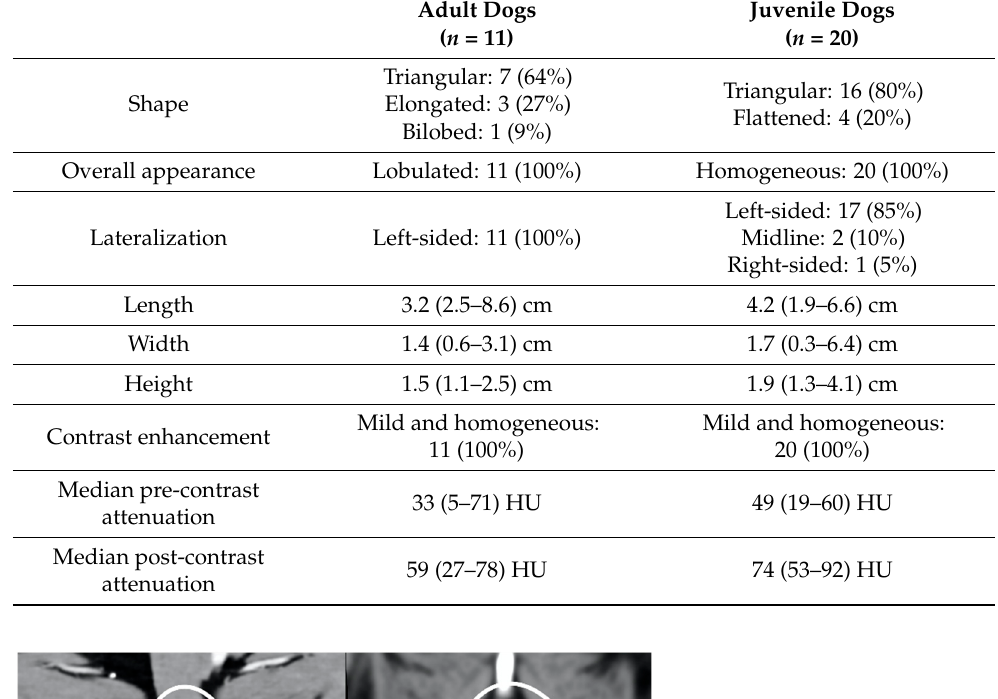
Table 1. CT features of the thymus in the dogs included in the study. Qualitative parameters are expressed as number (percentage) and quantitative parameters are reported as median (minimum– maximum).